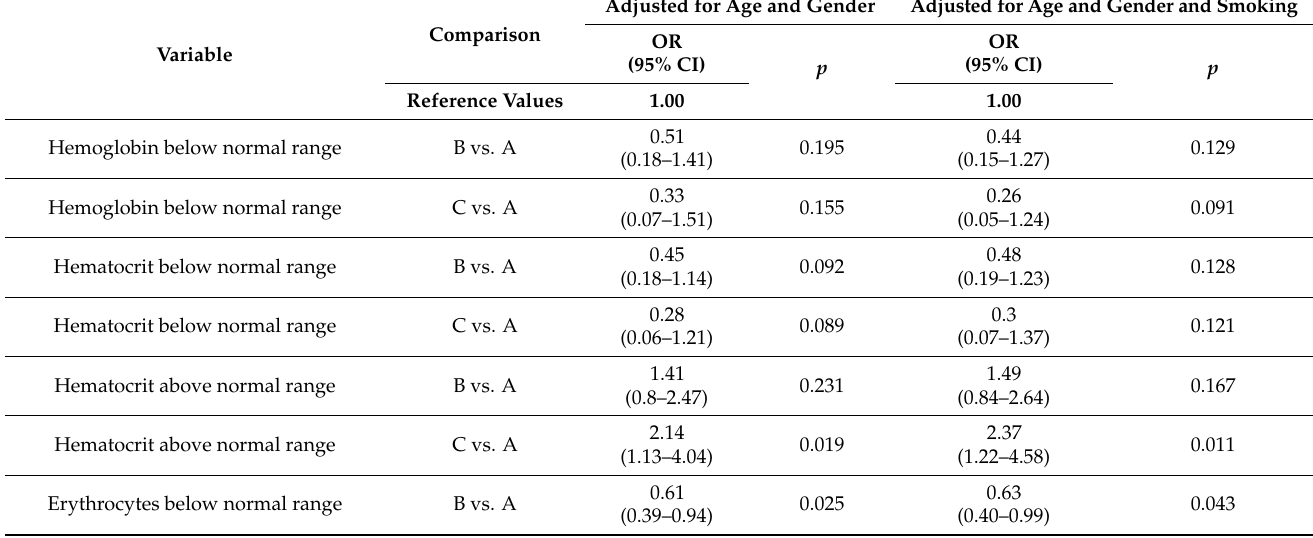
Table 7. Odds ratio for abnormal blood markers adjusted for age, gender,